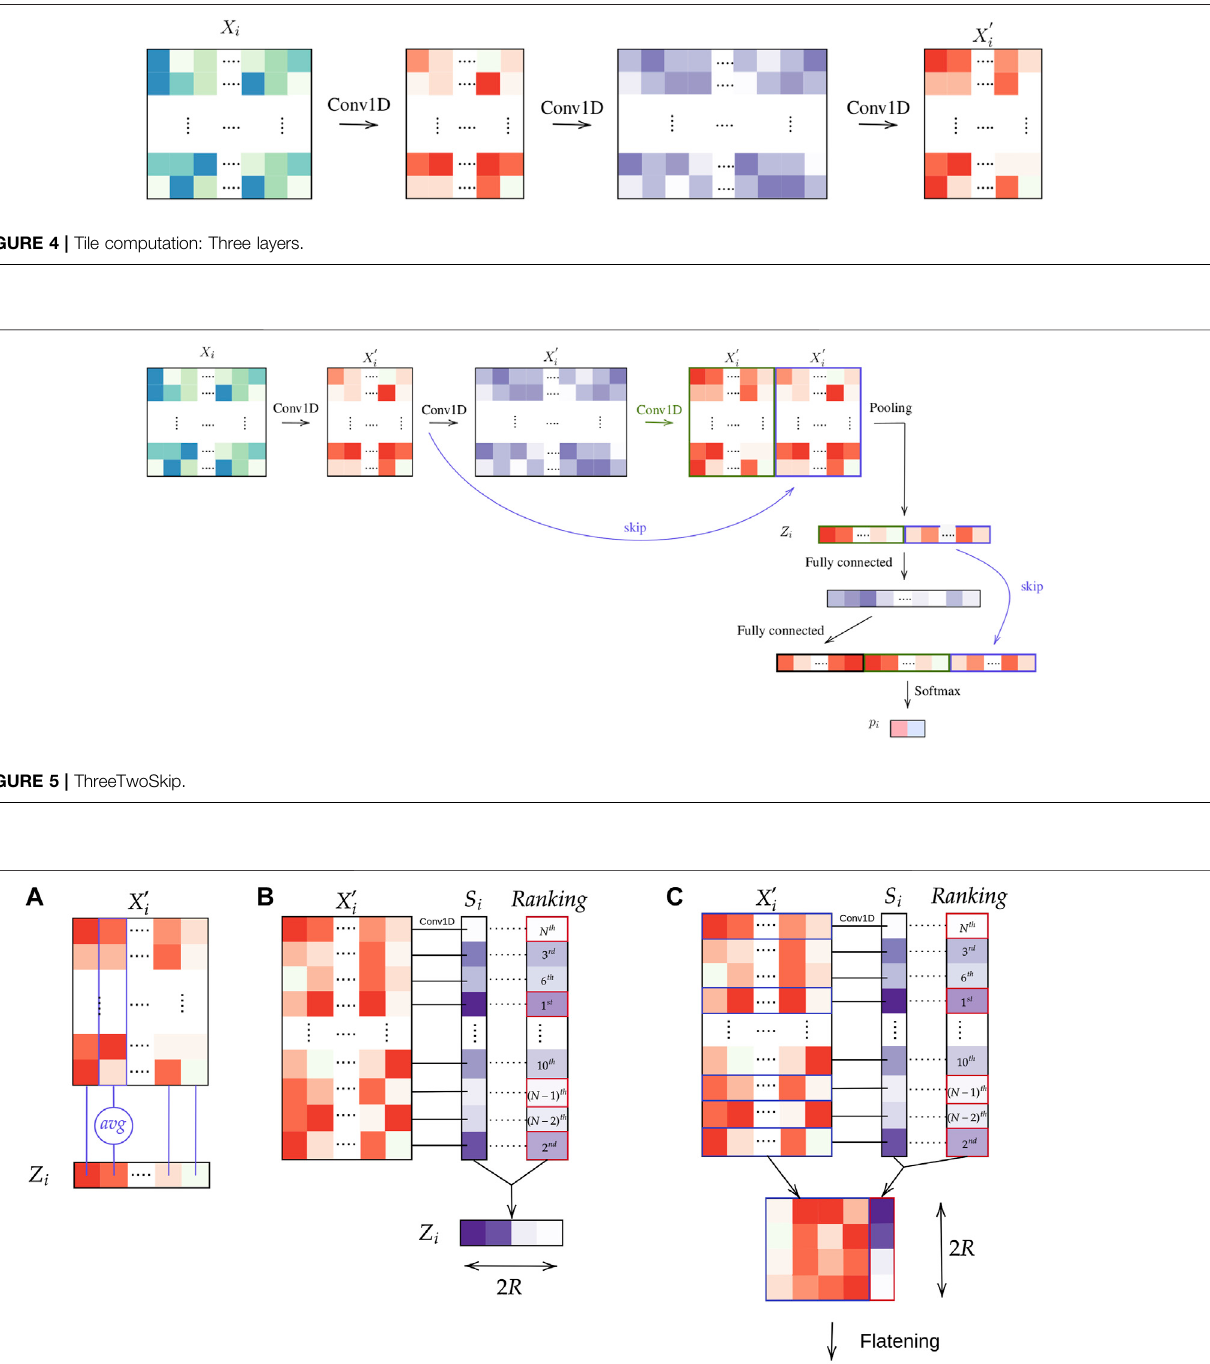
Frontiers in Signal Processing |